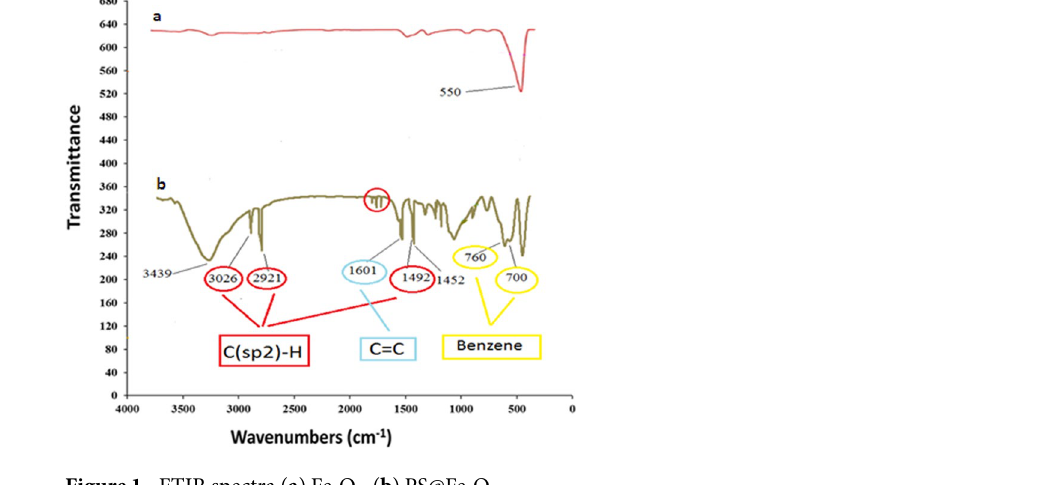
Figure 1. FTIR spectra ( a ) Fe 3 O 4 , ( b ) PS@Fe 3 O 4